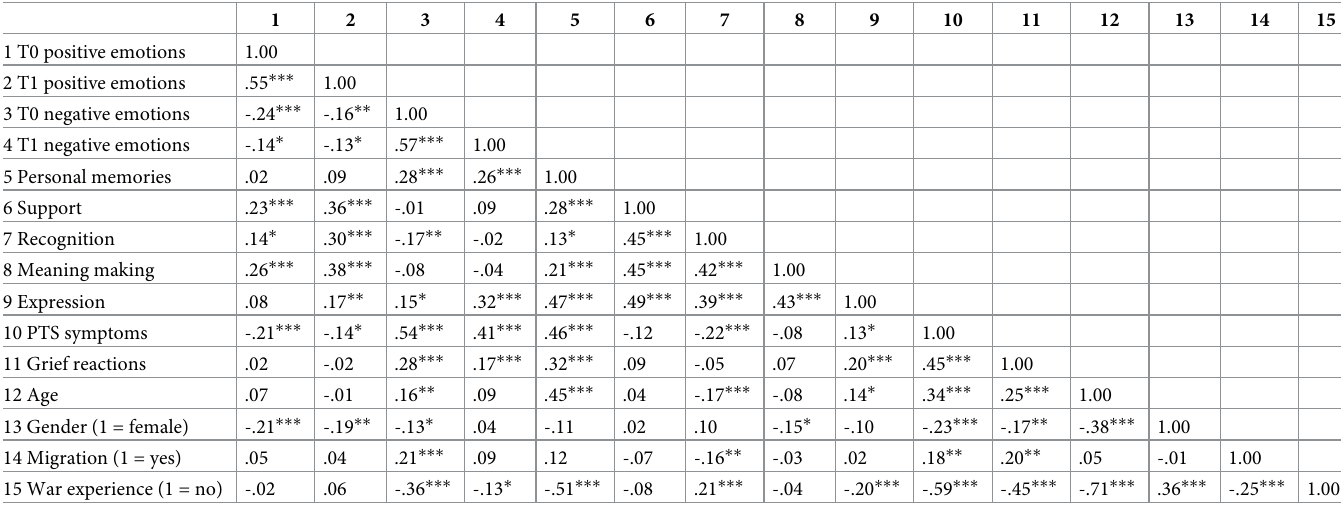
Table 2. Pearson correlations between outcome variables (positive and negative emotions T1) and predictor variables ( n = 272).